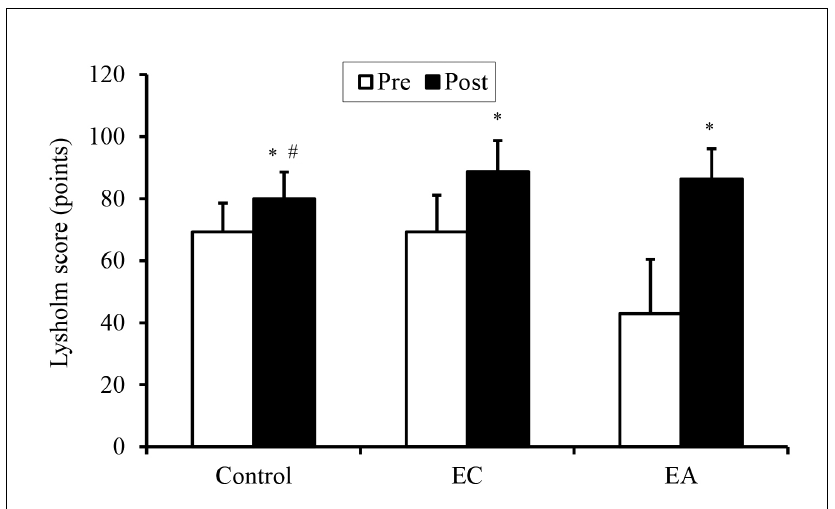
Note. * p < .05 comparing to pre intervention value, # p < .05 control compared to EC and EA